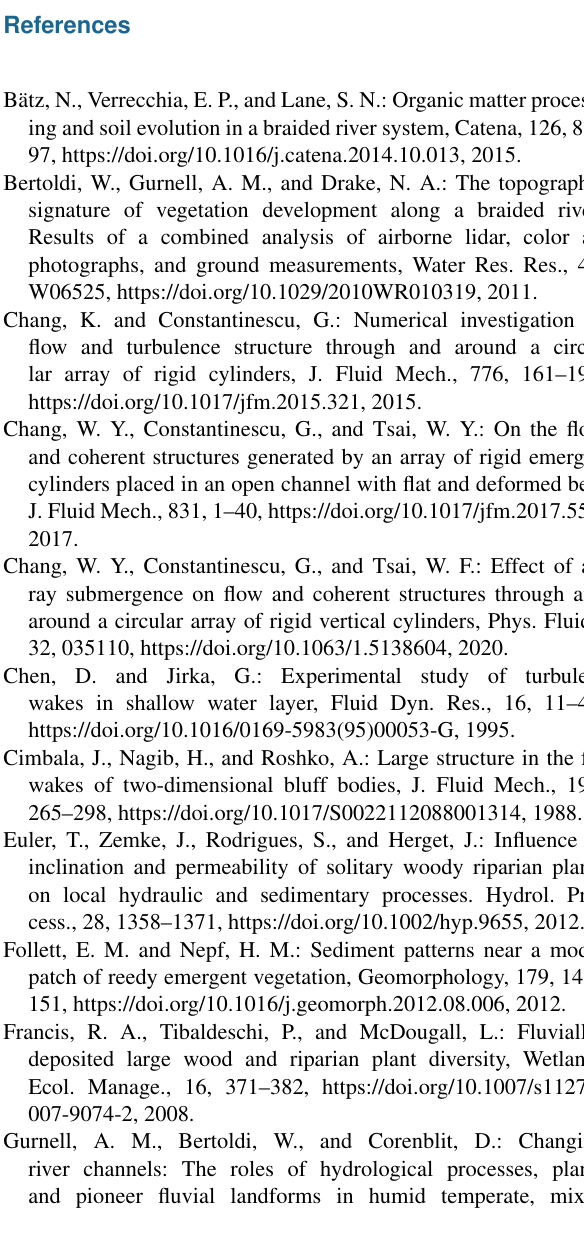
U , V and W are time-averaged streamwise, lateral and vertical components of the velocity vector, respectively; σ u , σ v and σ w are the turbulent fluctuations of the streamwise, lateral and vertical components of the velocity vector, respectively (cid:113) (cid:113) (cid:113) ( σ u = u (cid:48) 2 ,σ v = v (cid:48) 2 and σ w = w (cid:48) 2 ); − u (cid:48) v (cid:48) , − u (cid:48) w (cid:48) and − v (cid:48) w (cid:48) are the turbulent fluxes of momentum; and k is the turbulent kinetic energy.